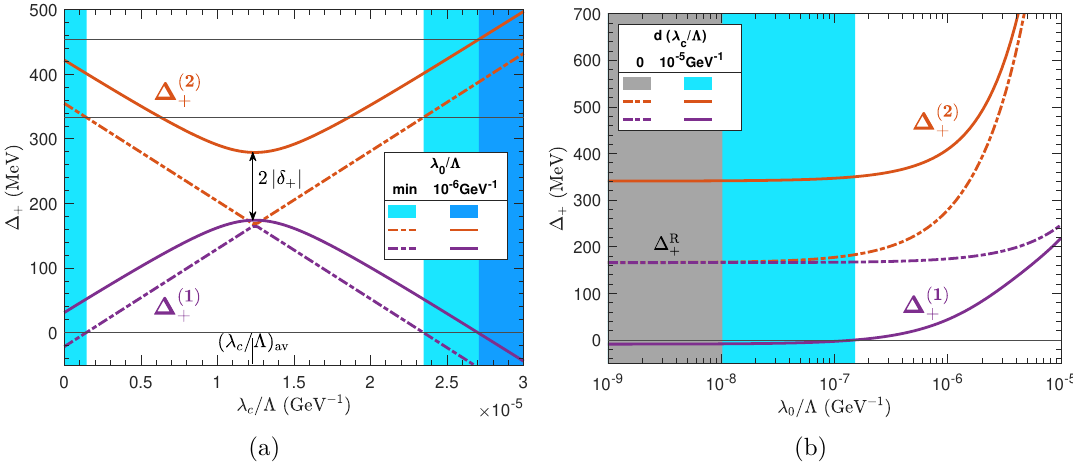
Figure 1. Left 1(a): mass splitting between the dark matter candidate χ 0 and the singly charged states χ + (in blue) and χ + (in red) as a function of the non-renormalisable coupling λ c / Λ for the 1 2 complex quadruplet. The figure shows mass-splitting for two values of the other non-renormalisable coefficient λ 0 / Λ . The curves corresponding to λ 0 / Λ = 10 − 6 GeV − 1 are in solid lines, while those at the minimum ( λ 0 / Λ) min = 10 − 8 GeV − 1 (2.28) are plotted in dashed-dotted style. The light (dark) blue shaded regions are excluded at minimum ( 10 − 6 GeV − 1 ) value of λ 0 / Λ as the theory cannot be considered as a dark mater model ∆ (1) < 0 according to (2.18) (2.19). Right 1(b): the right panel + illustrates the mass splitting of these fields ∆ (1) (blue) and ∆ (2) (red) with respect to the effective + + coupling λ 0 / Λ for the same quadruplet. The solid lines show the result in case the other coupling has d λ c / Λ = 1 . 1 × 10 − 5 GeV − 1 deviation from the mean value, and the dashed-dotted curves correspond to the average value of ( λ c / Λ) av = 1 . 2 × 10 − 5 GeV − 1 . In the light blue coloured region, the χ + field 1 becomes the lightest particle ∆ (1) < 0 as shown in (2.20), as λ c deviates from the mean, beyond the + range specified in (2.18). The grey shaded area is ruled out by DD experiments due to inelastic scattering of DM off target nucleus via exchange of Z boson at tree-level (2.28). Note that in both figures, the blue coloured regions still remain a valid beyond the Standard Model (BSM)